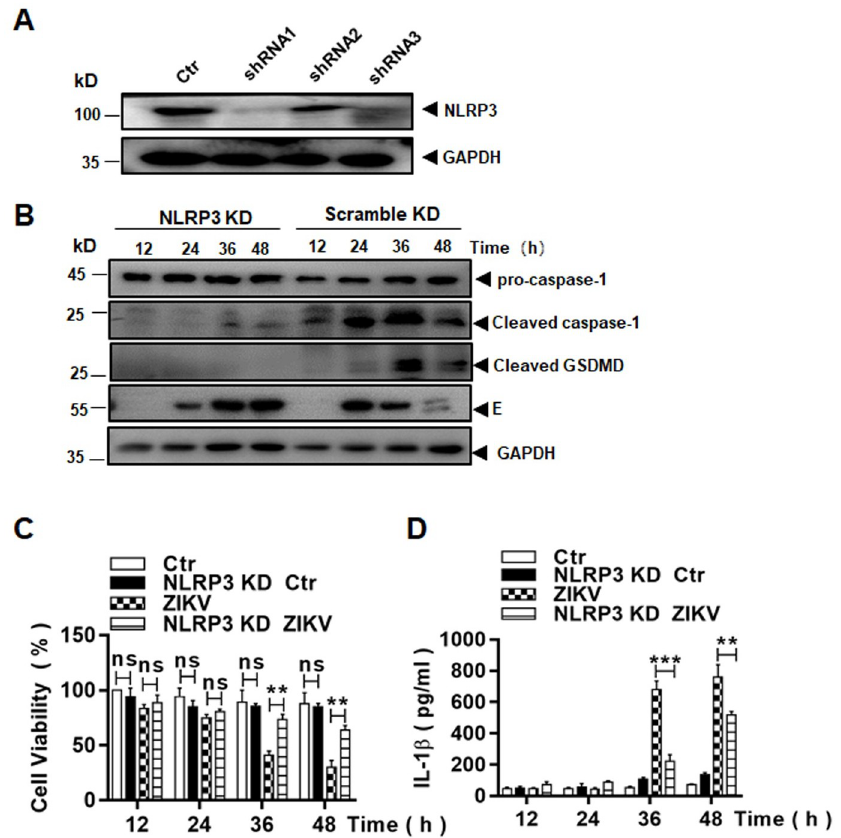
Fig 11. Pyroptosis triggered in ZIKV-infected monocytes were dependent on the NLRP3 inflammasome activation. ( A ) Knockdown of NLRP3 in THP-1 cells. Cell lysates were prepared from lentiviral vector-transduced THP-1 cell lines, expressing shRNA1, 2, or 3 targeting mRNA of NLRP3, for western blot analyses with an NLRP3 antibody to examine the knockdown (KD) efficacy. ( B ) Inhibition of pro-caspase-1 and GSDMD processing in NLRP3 KD cells. Both NLRP3 or scramble shRNA KD cells were infected with ZIKV and cell lysates, prepared at various time points p.i., were subjected to western blot analyses with antibodies for pro-caspase-1, cleaved caspase-1 and GSDMD. ( C ) Cell viability was assessed in NLRP3 or scramble shRNA KD THP-1 infected with or without ZIKV at various MOIs by an MTT assay. ( D ) Culture medium was sampled at various time points p.i. from NLRP3 or scramble shRNA KD cells, infected with or without ZIKV, for measurement of secreted IL-1 β by ELISA. The experiments were performed in triplicates and the data were shown as mean+SD and analysed by unpaired Students t-test. �� , P < 0.01; ��� , P < 0.001. ns, no